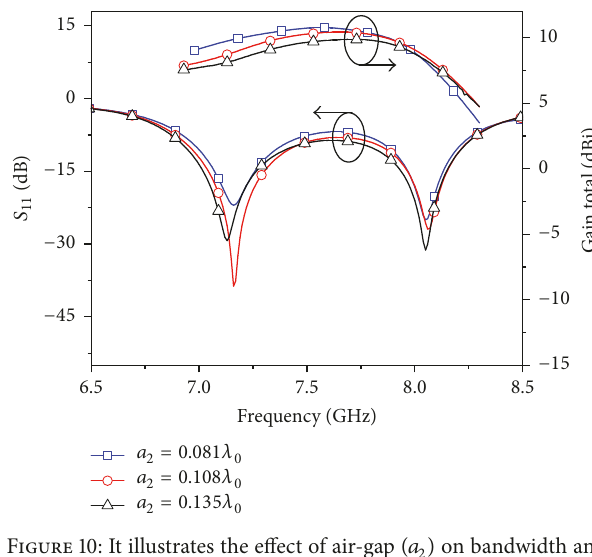
Figure 10: It illustrates the effect of air-gap ( 𝑎 2 ) on bandwidth and